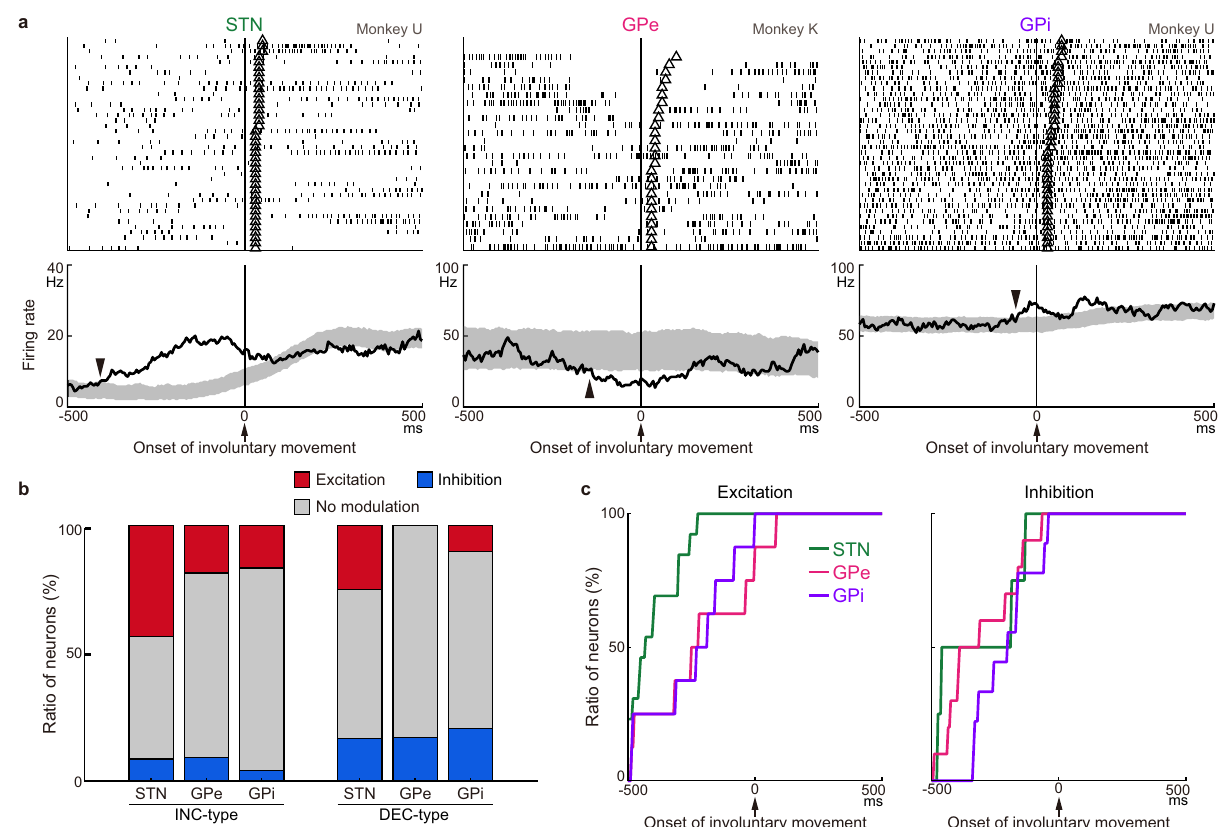
Fig. 6 Neural activity in relation to involuntary movements after reduction of STN activity. a Typical examples of STN/GPe/GPi neurons exhibiting excitation (STN and GPi) and inhibition (GPe) during involuntary movements. Spikes are aligned with the onset of involuntary movements, and trials are sorted by the duration of involuntary movements (The end of the involuntary movements was indicated by open triangles). In the PETHs (bin width, 5 ms; averaging window, 40 ms), solid lines and shading indicate averaged fi ring rates and 95% con fi dence interval estimated by a shuf fl ing method, and the onset of activity modulation is indicated by arrowheads ( − 400, − 135, and − 50 ms for STN, GPe, and GPi neurons, respectively). b Ratios of STN/GPe/GPi neurons exhibiting signi fi cant excitation or inhibition before the occurrence of involuntary movements among 25 STN, 43 GPe, and 24 GPi INC-type neurons, and 12 STN, 35 GPe, and 39 GPi DEC-type neurons. c Cumulative histograms of the modulation onset timings for the STN/GPe/GPi neurons with excitation (left) or inhibition